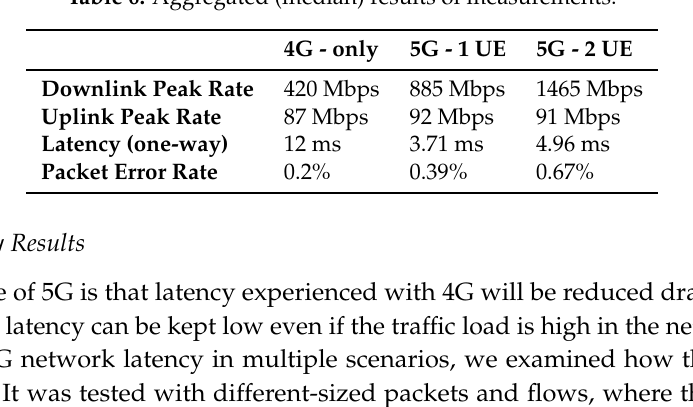
Table 6. Aggregated (median) results of